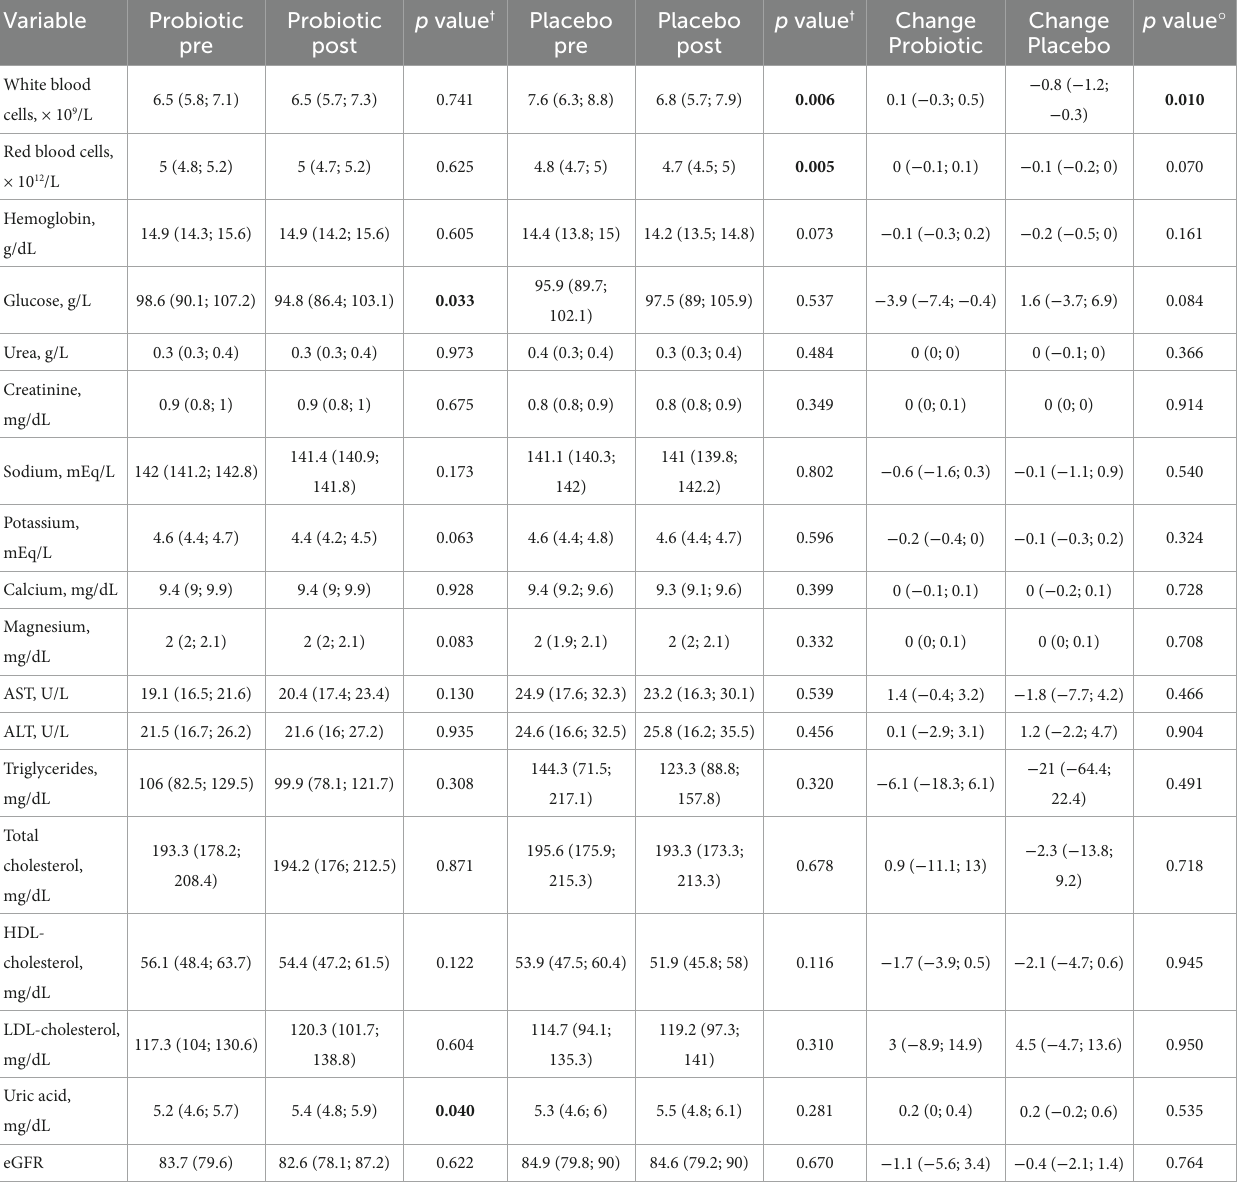
TABLE 3 Effect of the probiotic and placebo on biochemical parameters.